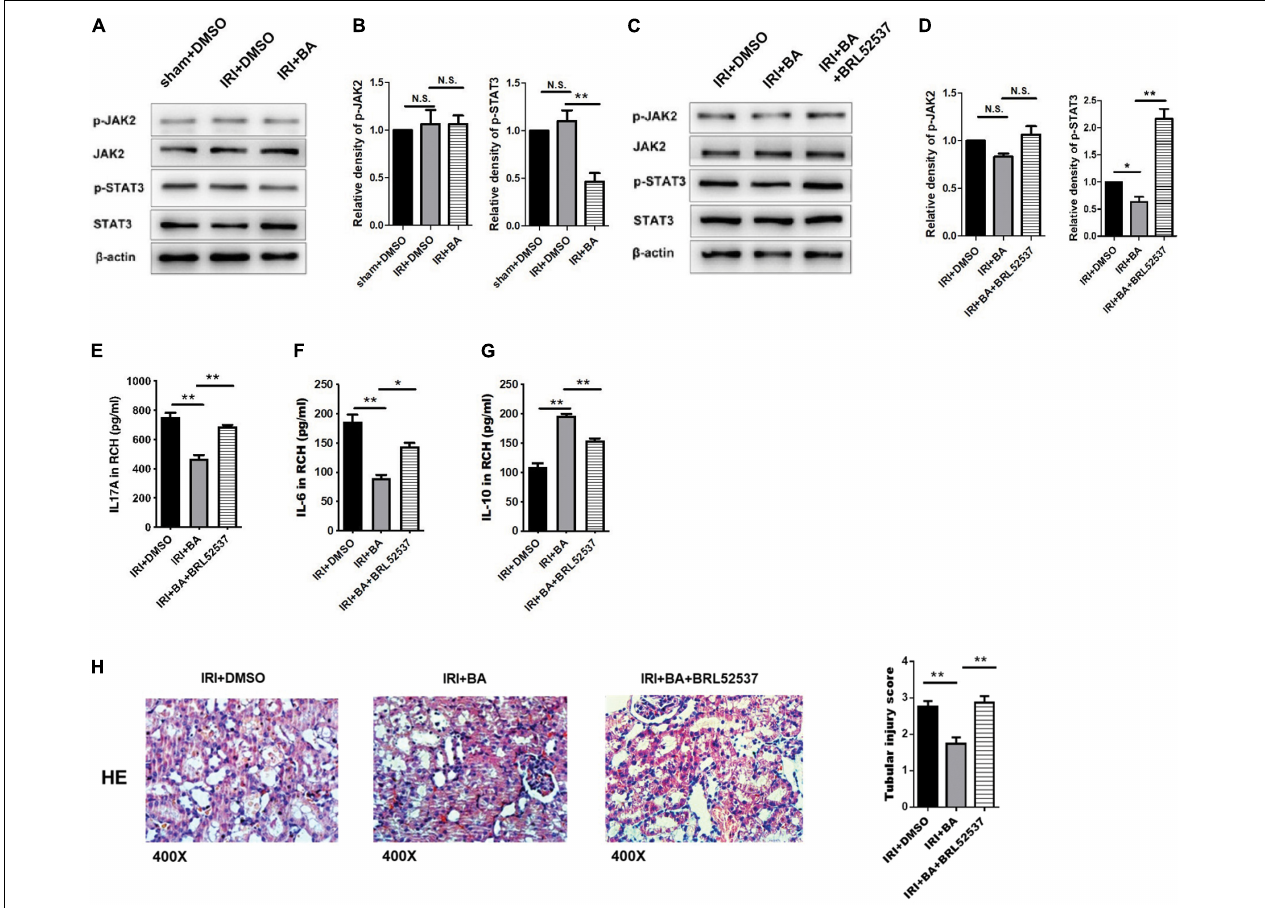
FIGURE 4 | BA protects against renal IRI via p-STAT3/SOCS3 signaling. (A,B) BA treatments attenuated the expression of p-STAT3 but not p-JAK2. (C,D) After BRL52537 treatment, the expression of p-STAT3 but not p-JAK2 was increased. (E–G) BRL52537 significantly attenuated the anti-inflammatory effects of BA on renal IRI. (H) HE staining indicated that BRL52537 significantly attenuated the protective effects of BA on renal IRI. Sample size = 3 in each group. Data were presented as mean ± standard deviation. N.S. P > 0.05, * P < 0.05, ** P <